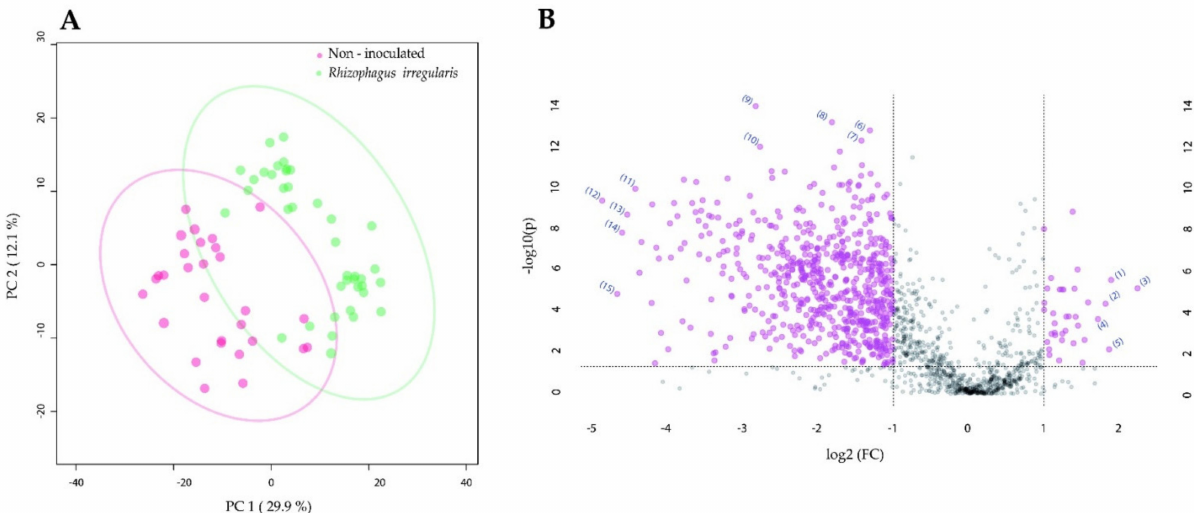
Figure 5. The impact of tomato root colonization by Rhizophagus irregularis on the fat body metabolome of Manduca sexta larvae. ( A ) Two-dimensional principal component analysis (PCA) scores plot of M. sexta fat body samples. ( B ) Significant metabolomic features annotated for the M. sexta fat body samples. Manduca sexta larvae were fed for three weeks on leaves of tomato plants that were non-inoculated, or root-inoculated with R. irregularis . In ( B ), the volcano plot displays fold change threshold ( x -axis) of 2 and t -test threshold ( y -axis) of 0.05. The purple circles represent features above the threshold. Both fold changes and p -values are log-transformed. The metabolomic features that showed the highest increase for the larvae reared on non-inoculated plants are found towards the right side of the volcano plot. The metabolomic features that showed the highest increase for the larvae reared on R. irregularis -inoculated plants are found towards the left side of the volcano plot. The most statistically significant metabolomic features for both treatments are found towards the top of the volcano plot. Table 4. The most significant metabolomic features annotated for the fat body samples of Manduca sexta larvae fed for three weeks on leaves of tomato plants that were non-inoculated and root- inoculated with Rhizophagus irregularis . The feature number corresponds to the features given in Figure 5B, which are given by their corresponding mass to charge ratio ( m / z ) and retention time (rt) in minutes. The fold change (FC) refers to the feature’s qToF intensity and was calculated on the basis of a volcano plot conducted for the non-inoculated and R. irregularis -inoculated larvae. The volcano plot was conducted with a fold change threshold ( x -axis) of 2 and t -test threshold ( y -axis) of 0.05. The level of confidence of the identification/annotation is given according to Malinowska and Viant [45]. Feature ID